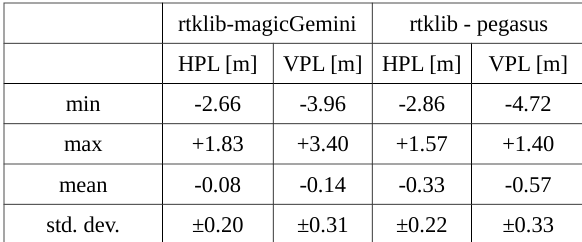
Table 1. Statistical characteristics of protection level differences calculated by different software